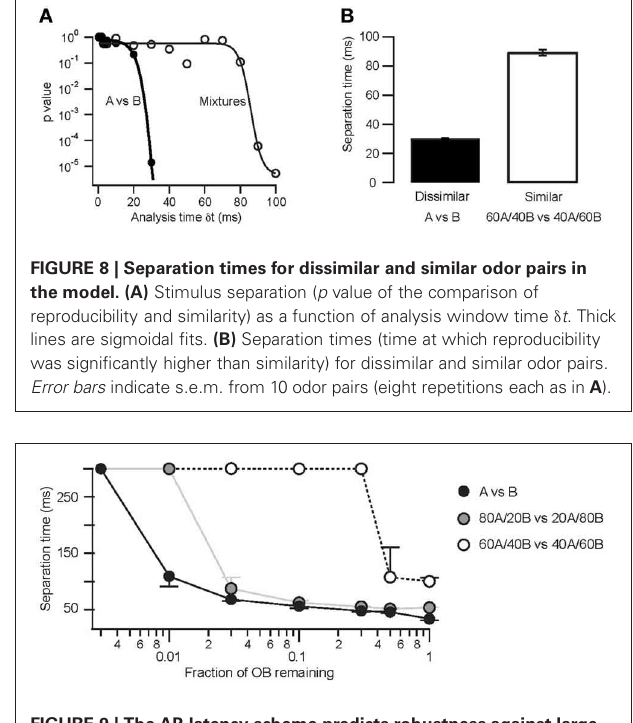
FIGURE 9 | The AP-latency scheme predicts robustness against large OB lesions. Separation times as a function of the size of a “virtual OB lesion” for dissimilar ( black ), intermediate ( gray ), and similar ( open ) odor pairs. Medians and their respective quartiles are